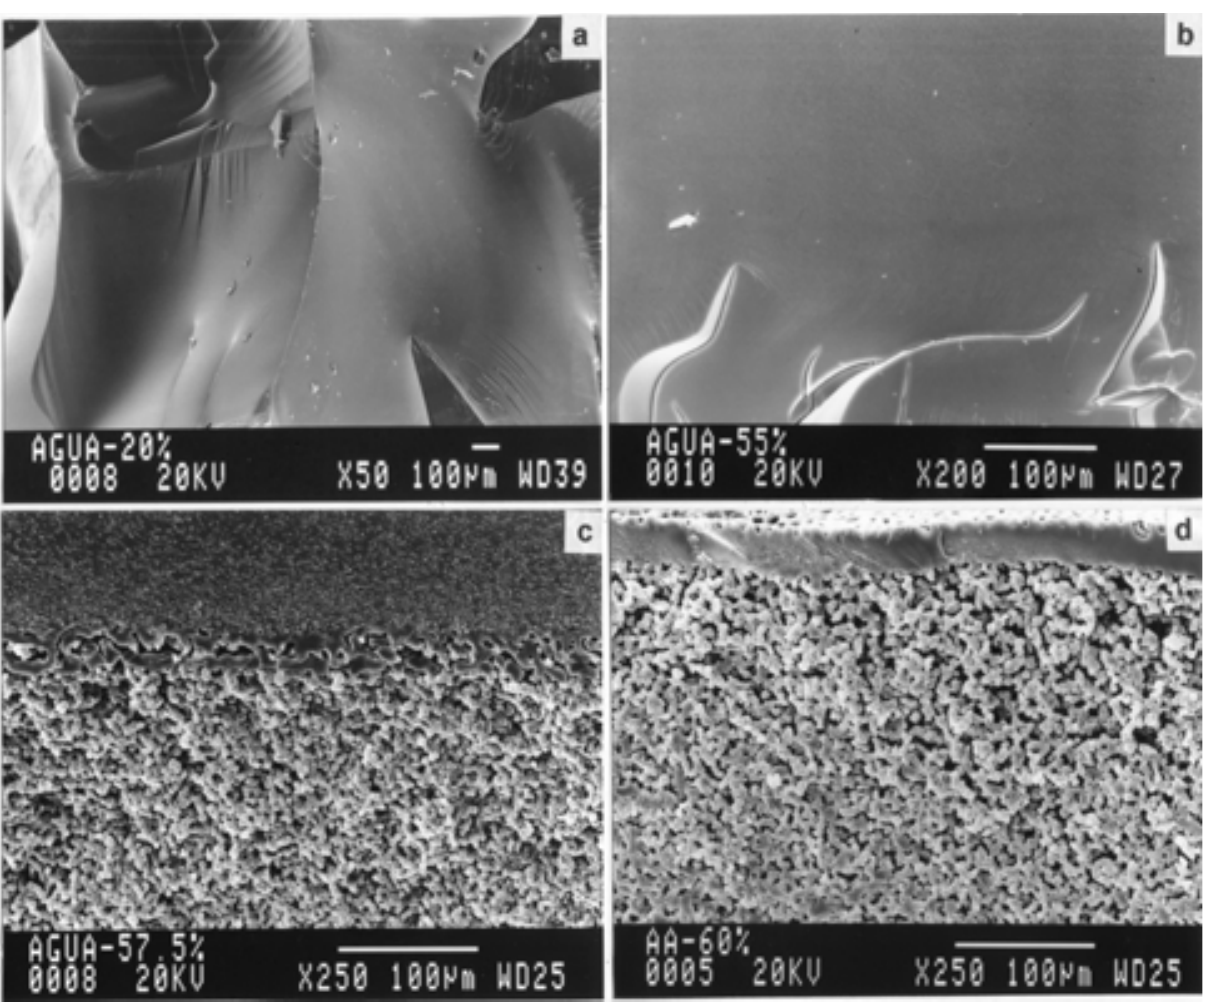
Figure 2. Photomicrography of polyHEMA porous sponge fractures in case of using: (a) NaCl crystals of diameter between 125-250 µ m and (b) sucrose crystals of diameter between 250-350 µ m, in bulk polymerization.